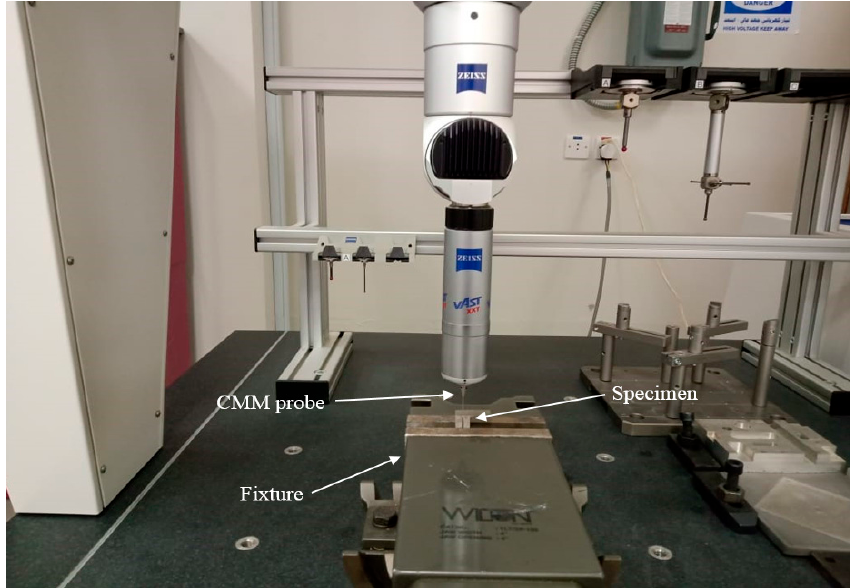
Figure 4. The coordinate measuring machine (CMM).